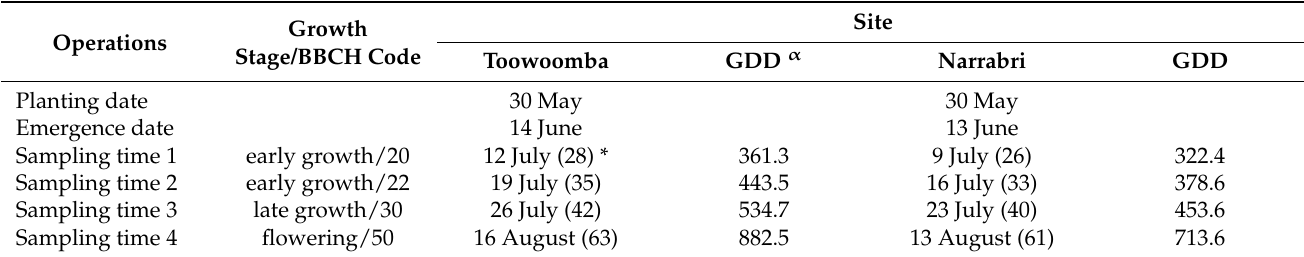
Table 2. Operations, date performed, and accumulation of growing degrees days (GDD) for faba bean cultivar pot experiments at Toowoomba, QLD and Narrabri, NSW